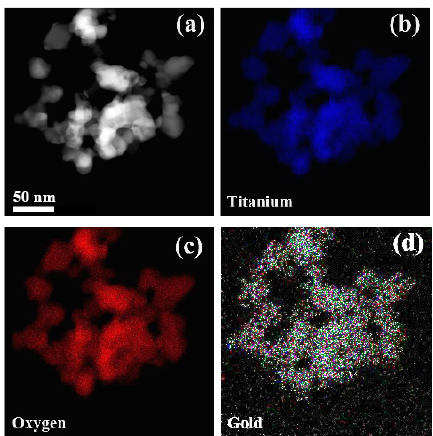
Figure 3. STEM–HAADF image ( a ) and low-magnification elemental mapping images of 2.43 × 10 − 3 % Au–S–CH 2 –CH 2 –OH / TiO 2 (0.5 g / L) sample ( b – d ). The elements were distinguished by the color: titanium (blue), oxygen (red) and gold (green).